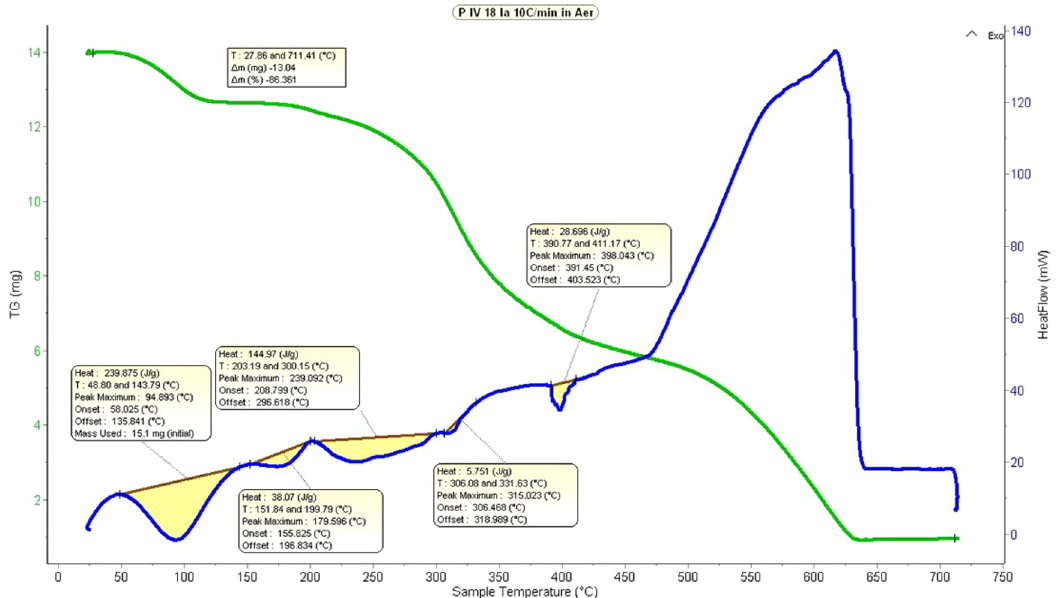
Fig. 8. DSC-TG spectra of TiO 2 -20wt.% SiO 2 hybrid